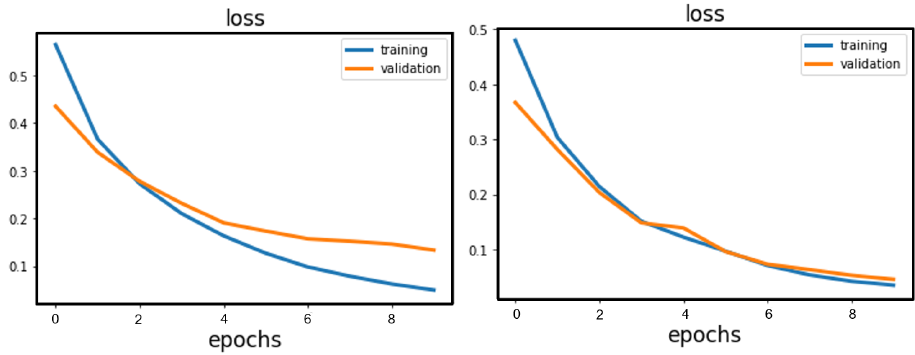
Figure 13. Loss curves for damage diagnosis models 1 ( left ) and 2 ( right ).